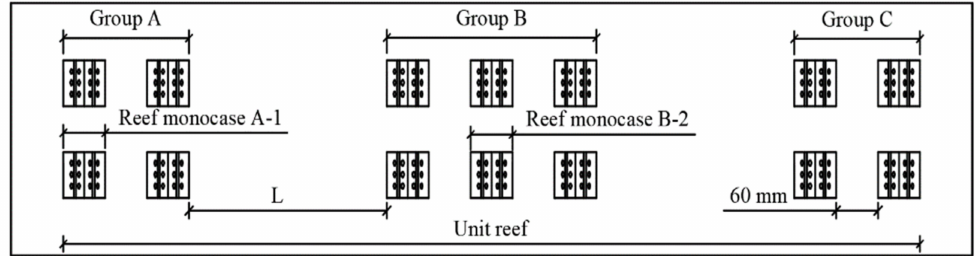
Figure 4. Composition of the reefs in the flume.